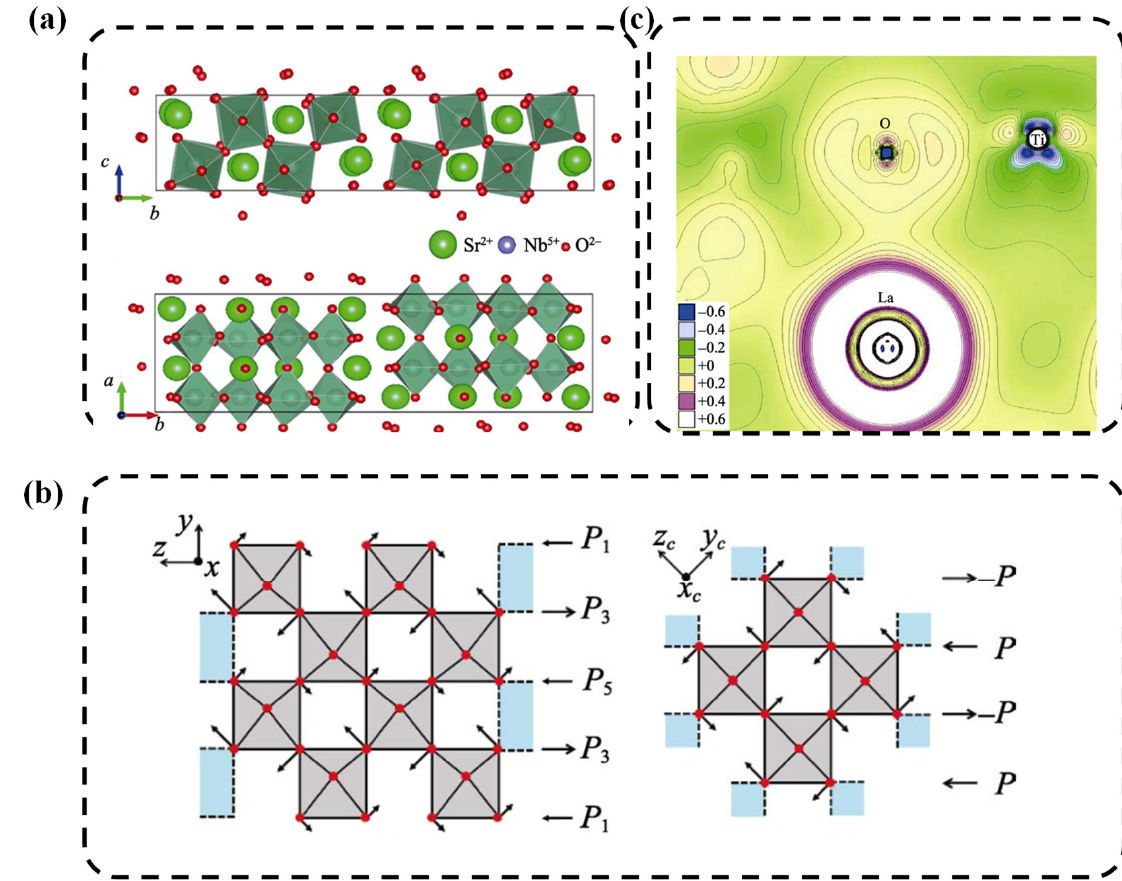
Figure 2. The perovskite layer-structured (PLS) piezoelectric ceramics. ( a ) Crystal structure of Sr 2 Nb 2 O 7 with visual angle along a (top panel) and along c (bottom panel). Reproduced with permission from Ref. [69]. Copyright 1975 Science Direct. ( b ) Left panel: schematic diagram of the largest atomic displacements associated with the strongest instability mode obtained for the Cmcm phase of La 2 Ti 2 O 7 ; Bottom panel: schematic diagram of a typical anti-ferrodistortive mode occurring in an ideal perovskite structure of BaTiO 3 . The arrows on the side represent the electric dipoles associated with the displacement of oxygens in a different y plane. Reproduced with permission from Ref. [74]. Copyright 2011 ISOLED. ( c ) Extracted valence-electron charge density for the monoclinic P 21 La 2 Ti 2 O 7 . Contour lines differ by 0.05 e Å − 3(1 Å = 0.1 nm). Reproduced with permission from Ref. [75] Copyright: 2010 American Institute of Physics.